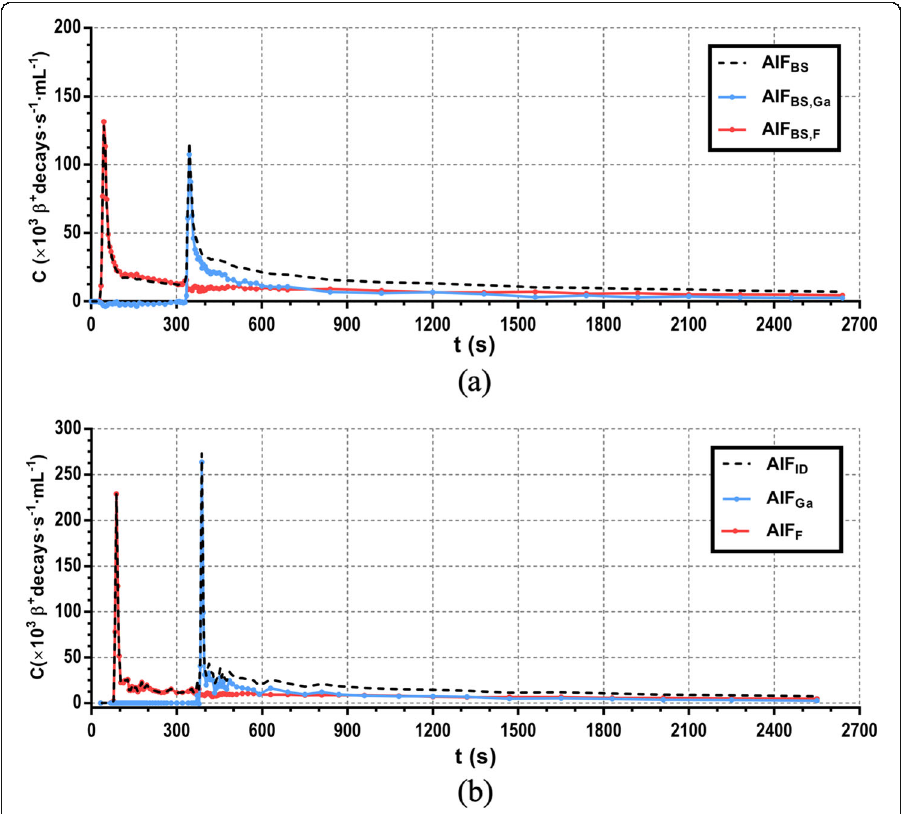
Fig. 6 a AIF BS,F (red) and AIF BS,Ga (blue) obtained from manual blood sampling during PET scan applying the spectroscopic method. The black dashed line shows the sum of both tracers. b AIF ID (black dashed line) obtained from the dynamic PET images using an ROI drawn in the descending thoracic aorta and delay corrected and dispersion-free contributions from 18 FDG (red) and 68 Ga-DOTA (blue) obtained as detailed in